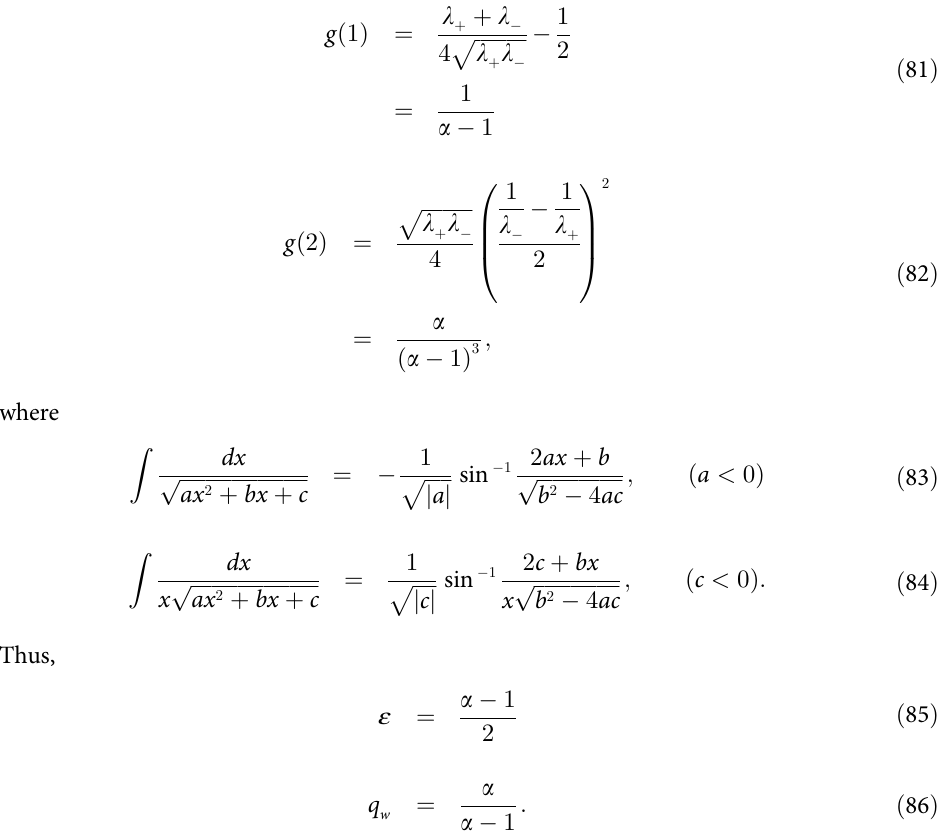
S1 Data. Figure 1 from S1